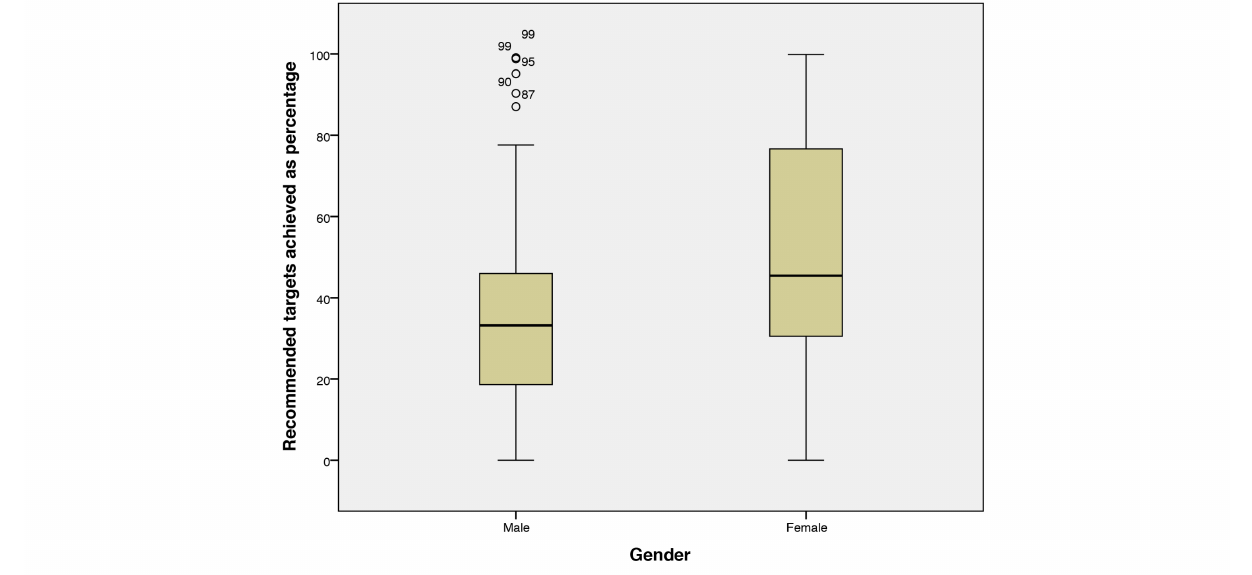
Figure 11. Boxplot showing distributions of male and female mean percentages of achieved targets across all